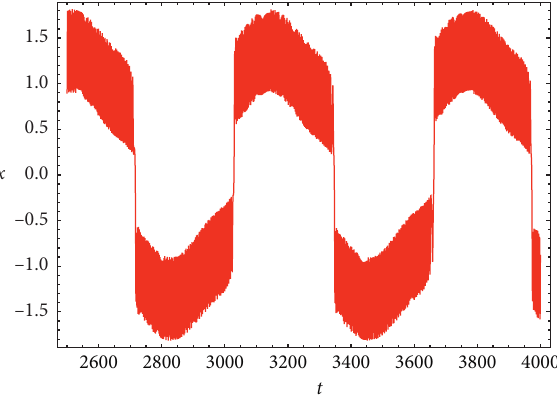
5: The time series for